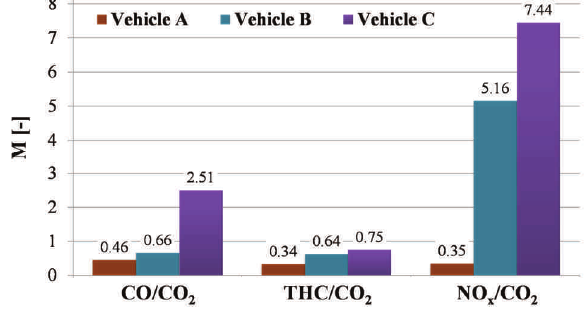
Fig. 9. Summary of toxicity index M for CO, THC, and NO